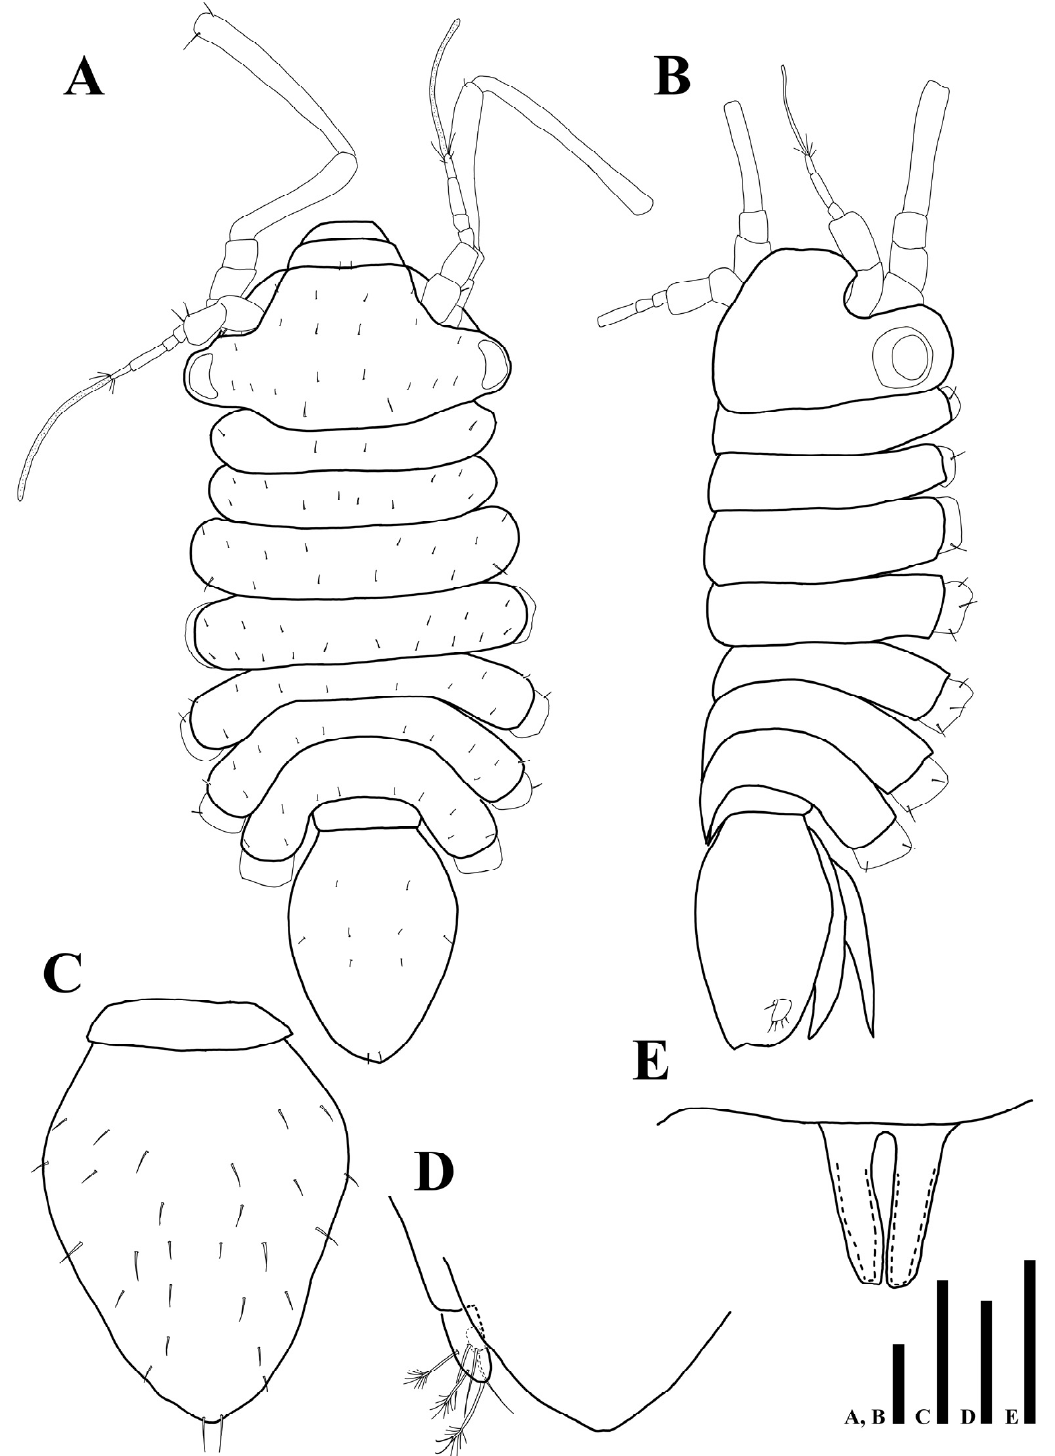
Figure 2. Uromunna mundongensis sp. n. holotype male: ( A ) habitus; ( B ) habitus, dorsolateral; ( C ) pleotelson; ( D ) uropod; penial papillae. Scale bars = 100 μ m ( A ‒ C ), 50 μ m ( D , E ). Antennula (Figure 3A): six articles; first article 1.1 times longer than wide, with two plumose setae; second article 1.2 times longer than first article, 1.7 times longer than wide, with four plumose and four simple setae distally; third article rectangular, 1.4 times longer than wide, with one simple setae distally; fourth article 1.3 times longer than wide,